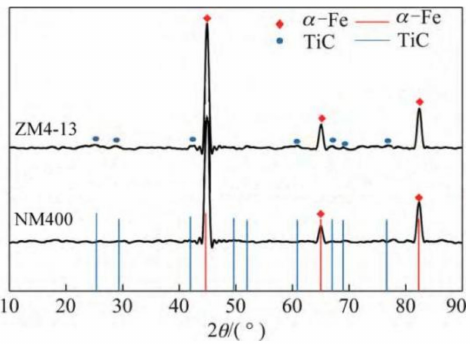
Figure 2. XRD patterns of samples and standard X-ray diffraction peaks of α -Fe and TiC.